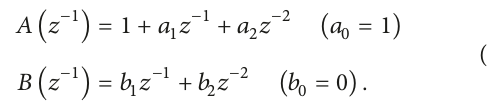
Algorithm 1 (algorithm for estimating the time delay using the cross-correlation